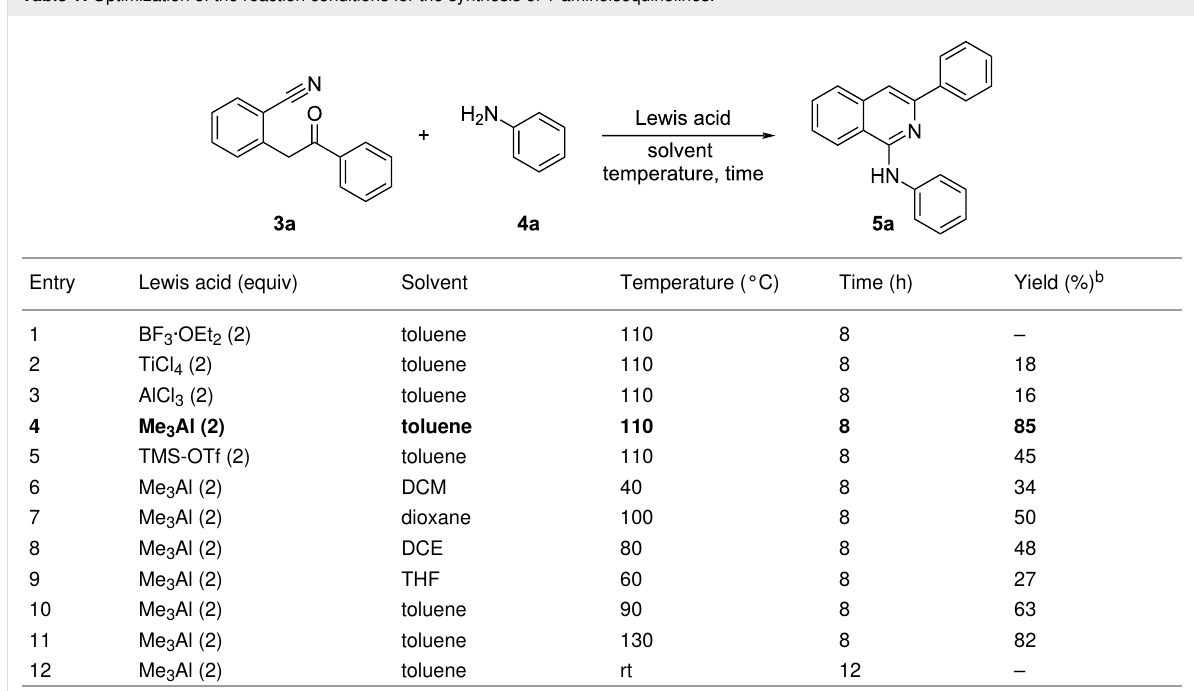
Table 1: Optimization of the reaction conditions for the synthesis of 1-aminoisoquinolines.